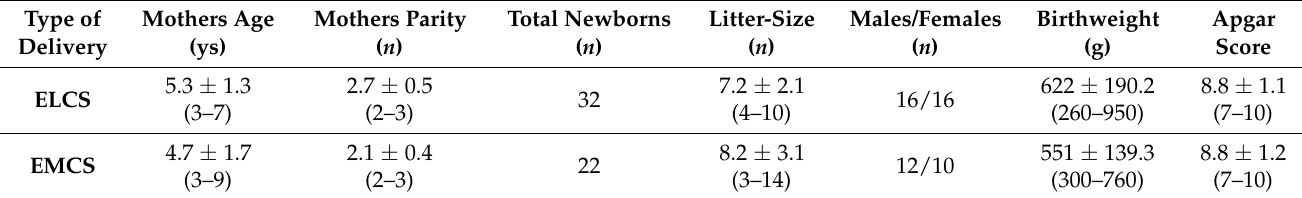
Table 1. Data expressed as mean ± SD and (min-max) about the maternal and neonatal clinical findings in elective Caesarean section (ELCS) and emergency Caesarean section